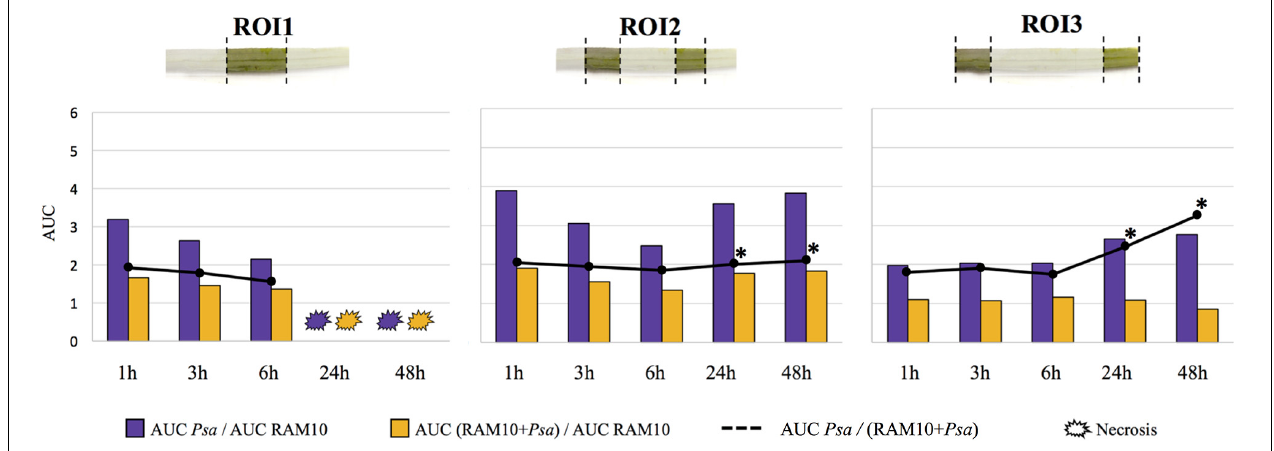
FIGURE 5 | Evolution of cumulative H 2 O 2 fold induction triggered by P. syringae pv. atrofaciens in leaves of Psa and RAM10 + Psa plants relatively to RAM10 ones (bars), expressed as the ratio between the respective area under curves (AUC) at each time post-infection. The degree of RAM10-mediated alleviation of H 2 O 2 accumulation in leaf tissue, calculated as the AUC ratio between Psa -triggered H 2 O 2 production in Psa plants relatively to RAM10 + Psa ones, is represented by black lines. Asterisks show statistically significant differences ( p < 0.05) of the ratio AUC( Psa )/AUC(RAM10 + Psa